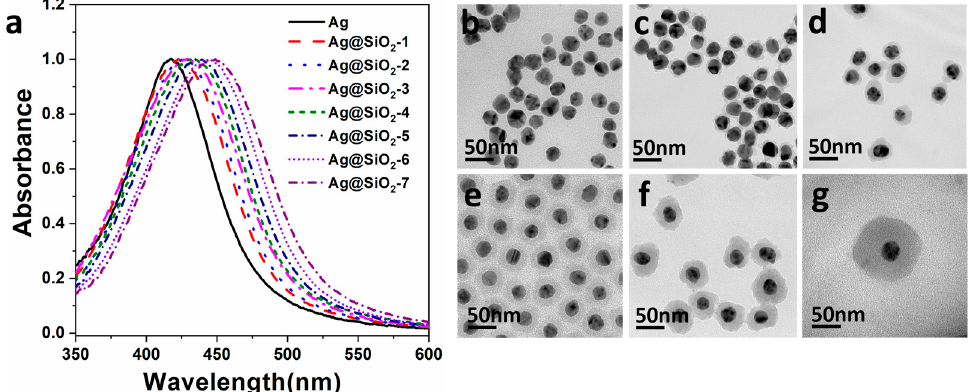
Figure 2. ( a ) The absorption spectra of silver (Ag) nanoparticles (black solid line) and the absorp- tion spectra of Ag@SiO 2 samples prepared by adding 5, 10, 15, 20, 25, 40, and 80 μ L TEOS (dashed line from left to right); TEM images of Ag nanoparticles ( b ) and Ag@SiO 2 samples with SiO 2 thick- ness of ( c ) 2 nm, ( d ) 12 nm, ( e ) 18 nm, ( f ) 20 nm, and ( g ) 35 nm, respectively.